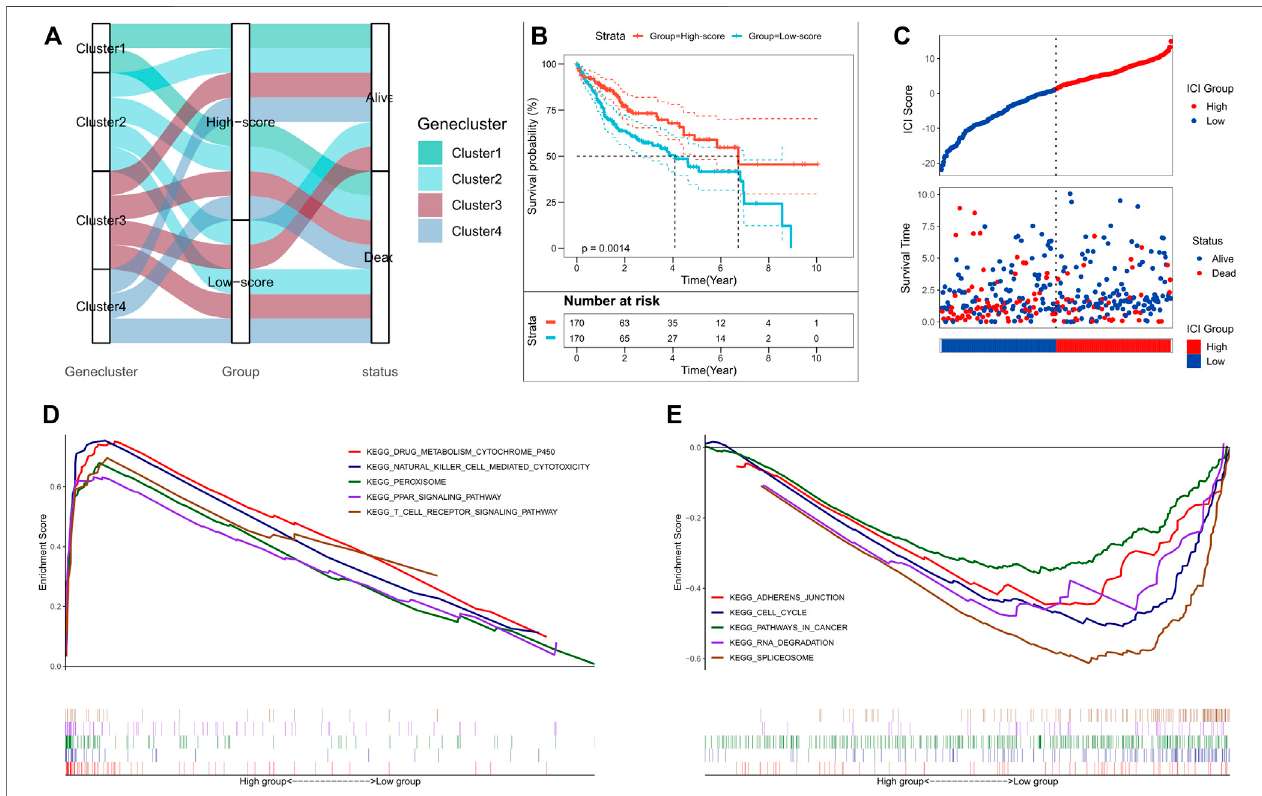
FIGURE 3 | Construction of the ICI scores. (A) Alluvial plot of the ICI gene cluster distribution in subgroups with different ICI clusters, ICI scores, and survival outcomes; (B) Kaplan-MeiercurvesforthehighandlowICIscoresubgroupsintheTCGAcohort,where p (cid:1) 0.0014forthelog-ranktest; (C) Survivalstatusofpatientsin thehighandlowICIscoresubgroupsintheTCGAcohort; (D) GSEAenrichmentresultsforthehighICIscoresubgroup; (E) GSEAenrichmentresultsforthelowICIscore subgroup.